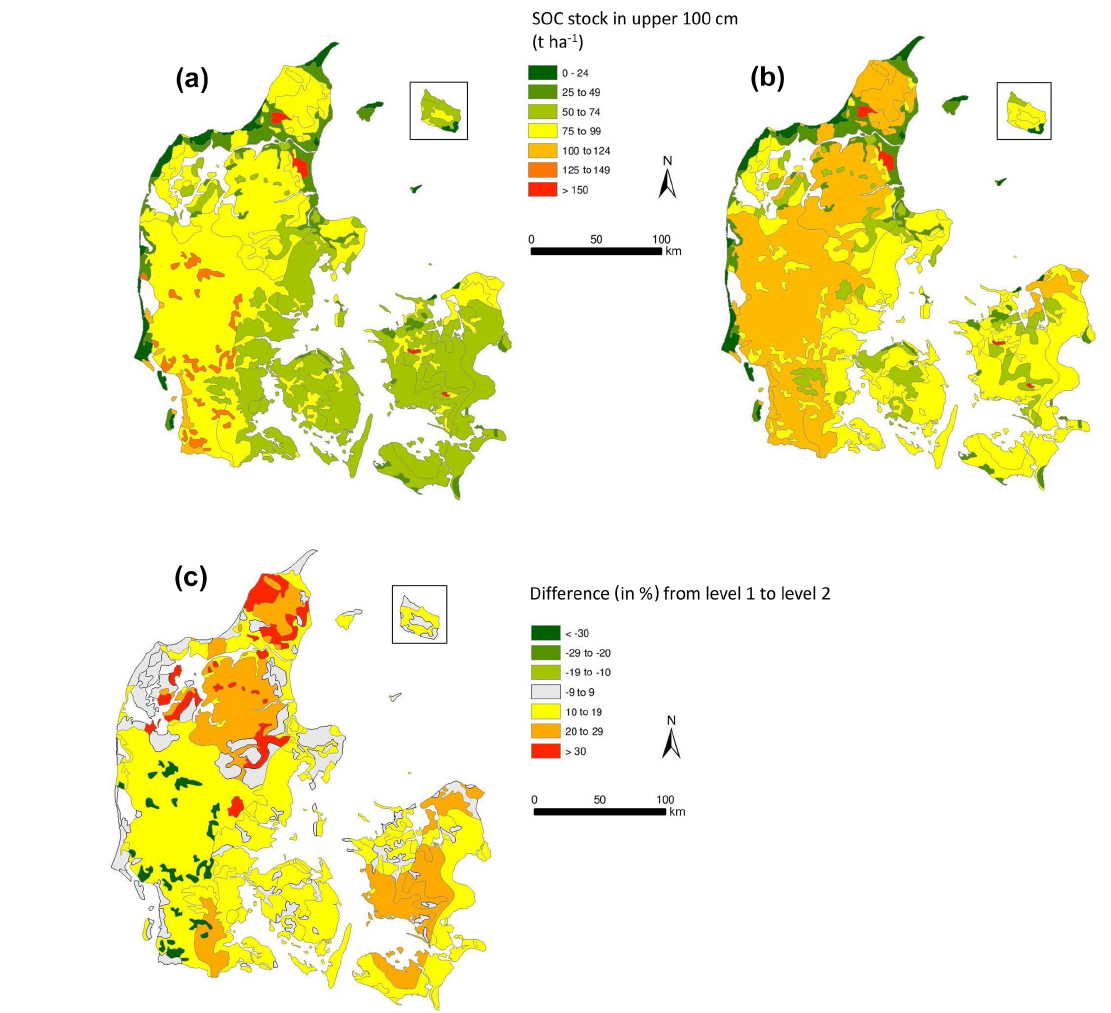
Figure 4. Soil organic carbon stocks (tha − 1 ) in Denmark within the upper 100cm of the soil calculated based on (a) SPADE 14 level-1 data and (b) SPADE 18 level-2 data. (c) Shows the relative change from level 1 to level 2 (in